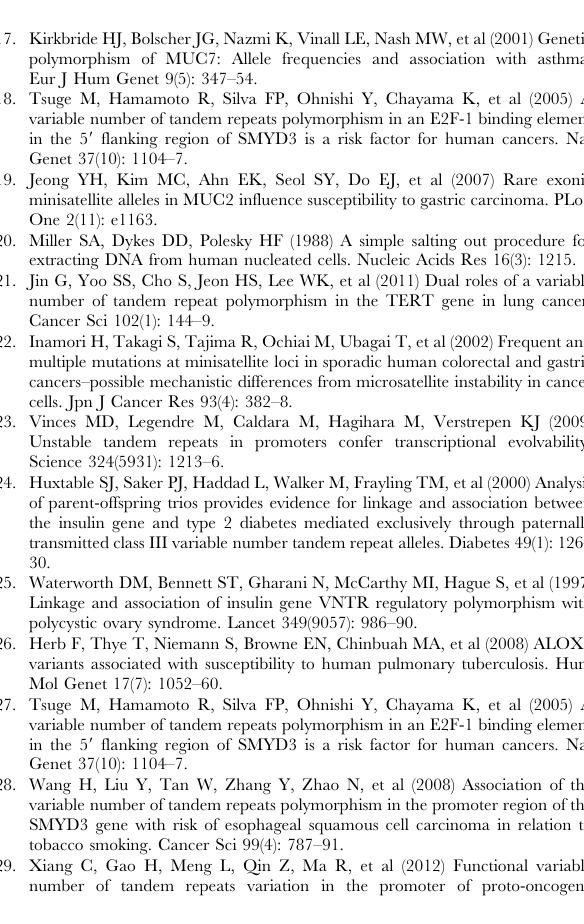
Table S1 Distributions of selected characteristics in gastric cancer cases and controls. Table S2 TNM stages in cases of gastric cancer. Table S3 Distribution of MUC5AC-u repetitive region geno- types in gastric cancer cases and